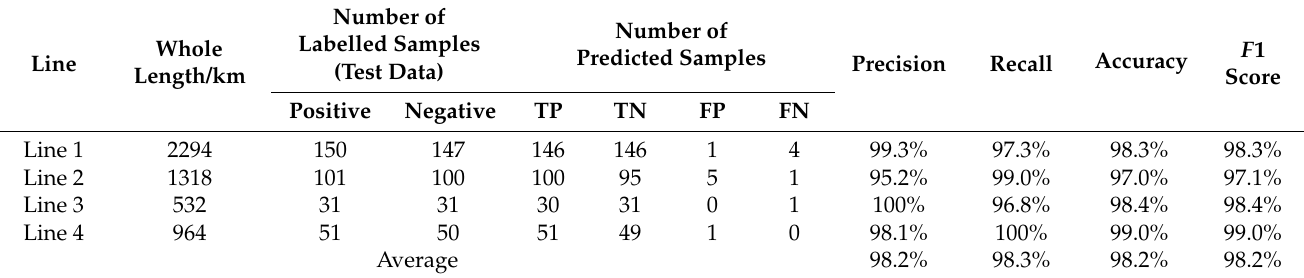
Table 2. Statistics of evaluation indices of 1DCNN.